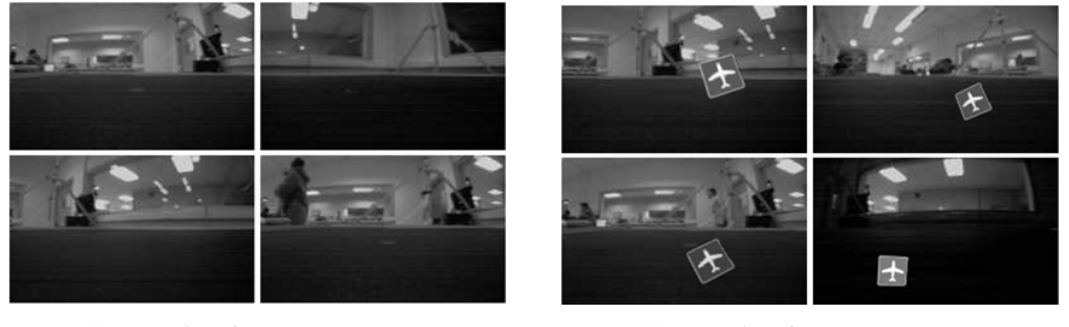
Figure 6. Examples of images acquired by the